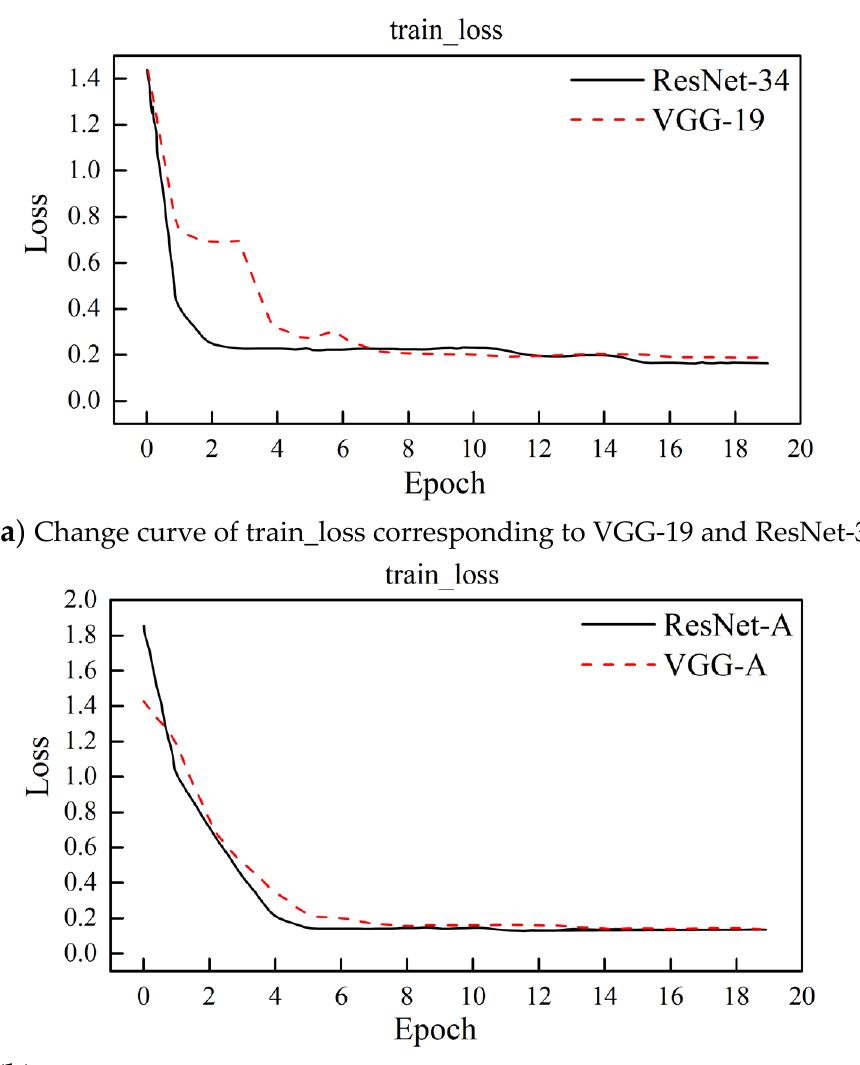
Figure 5. Change curves of train_loss. Table 1. Test